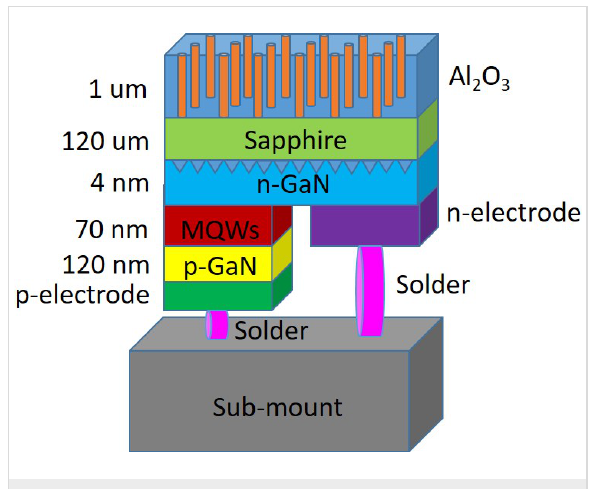
Figure 12: Structure of flip-chip LED with anodic aluminum oxide (AAO)